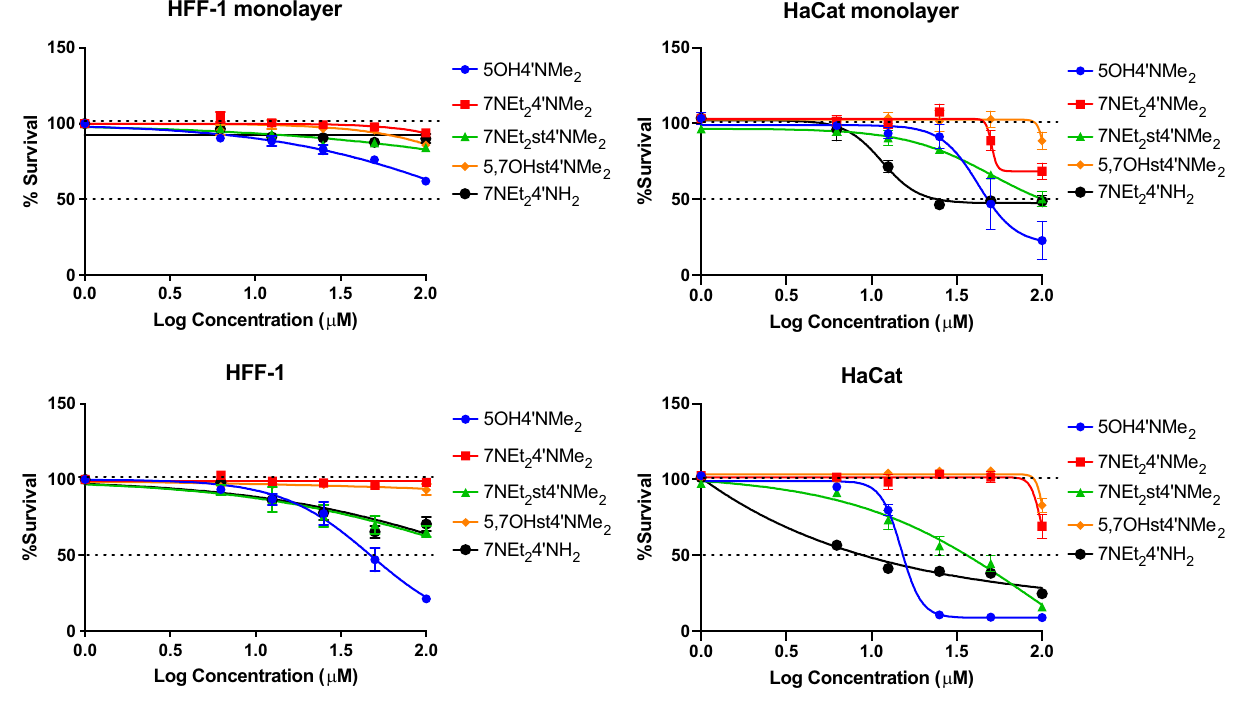
Figure 4. Effect of compounds on HFF-1 and HaCaT cells proliferation evaluated by the MTT assay. Both cell lines were seeded in 96 well plates and then treated with a concentration range (0.00–100.00 µM) of each compound for 48 h. Each value represents the mean ± SEM (n =